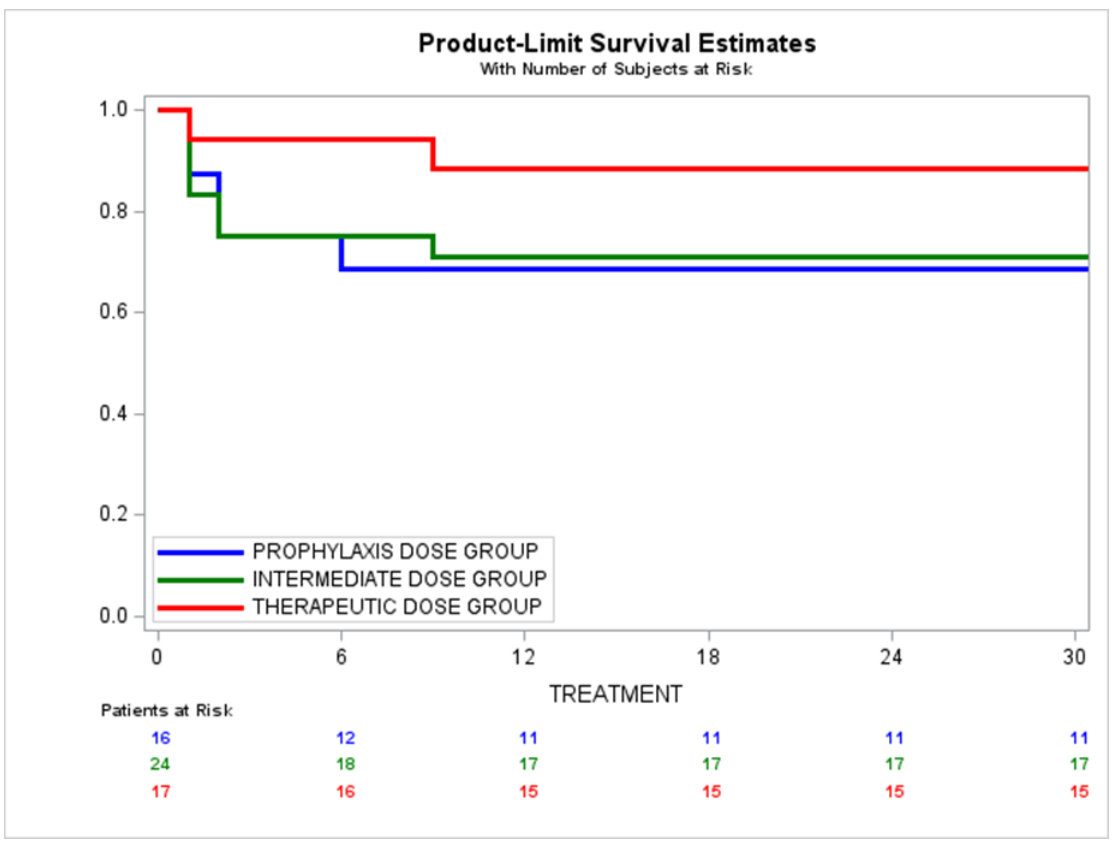
Figure A3. Survival analysis stratified by D Dimer ≥ 1000. A subanalysis was performed evaluating only those patients with a D-dimer value ≥1000. The combined event of presenting Thrombotic Event and/or NIMV and/or death from any cause and/or High Flow and/or ICU before 30 days from randomization was considered; those patients who did not present an event were censored at 31 days. No statistically significant differences in survival were detected between the three treatment groups. The p -value associated with the Wald statistic (1.8037) is 0.4058 >